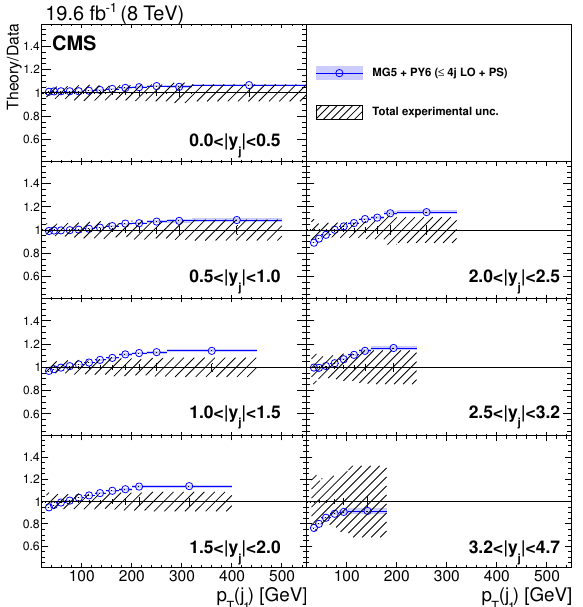
)d y (j ) obtained 1 1